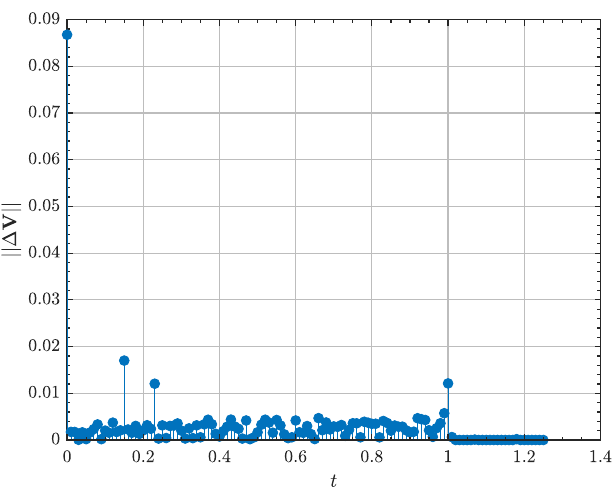
Figure 23. Control input in m/s for the Lunar Gateway resupply mission during the close-range